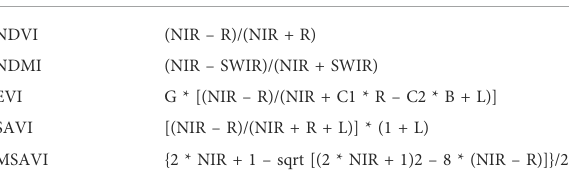
TABLE 1 Spectral indices used for time series and land cover changes analyses.Normalizeddifferencevegetationindex(NDVI),normalized differencemoistureindex(NDMI),enhancedvegetationindex(EVI),soil- adjusted vegetation index (SAVI), and modi fi ed soil-adjusted vegetation index